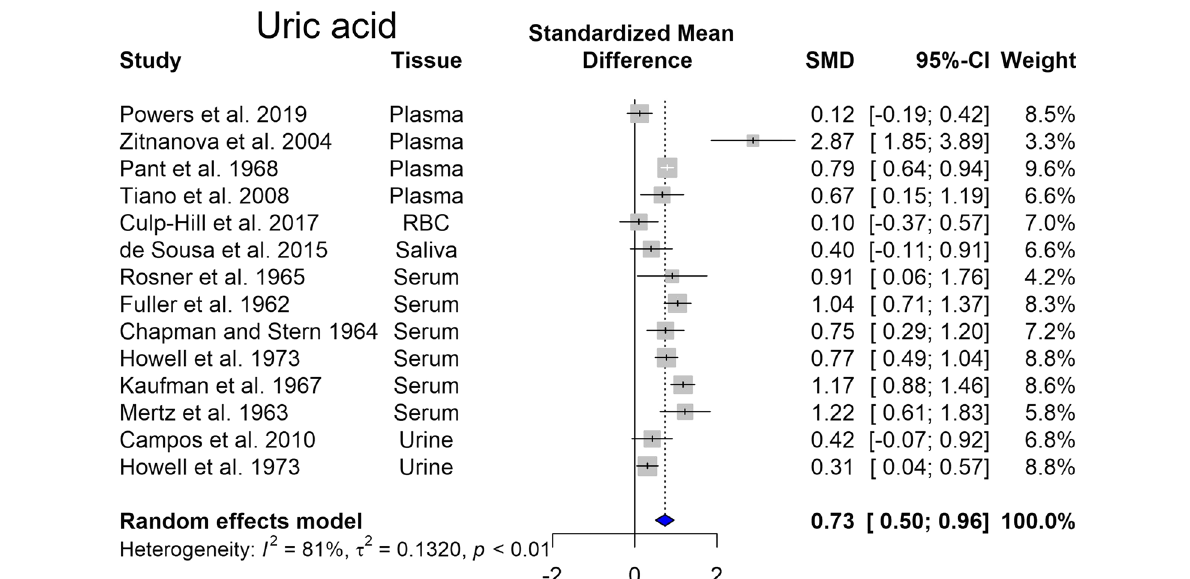
Fig. 2 Changes in uric acid in Down syndrome. Forest plot showing relative weights, standardized mean difference (Hedges’ g) with confidence intervals. Overall average effect size is displayed by filled